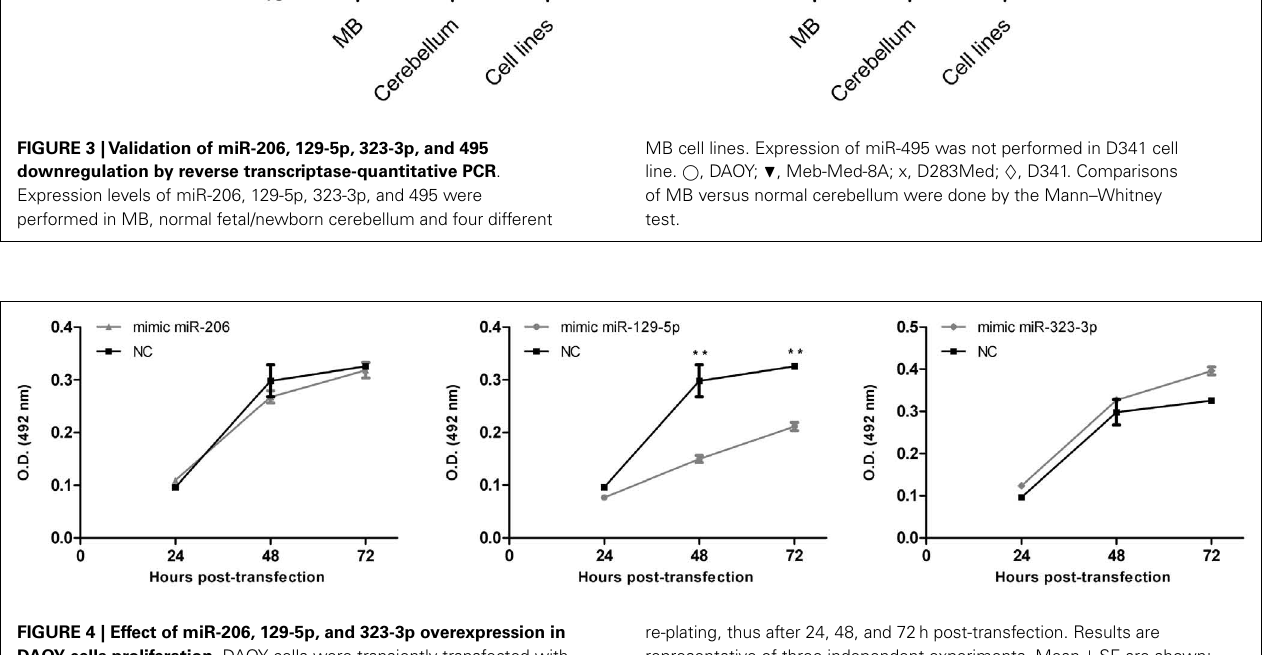
FIGURE 4 | Effect of miR-206, 129-5p, and 323-3p overexpression in DAOY cells proliferation . DAOY cells were transiently transfected with miRNAs mimic and replated after 20h at a 1,500 cells/well density. Cell proliferation was evaluated by the MTS assay at 4, 28, and 52h after